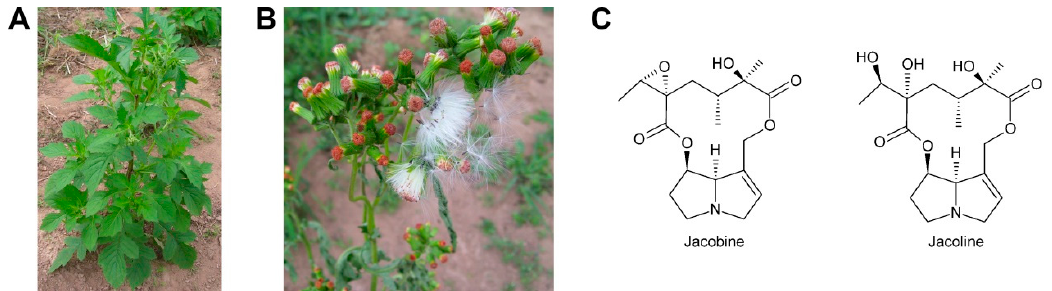
Figure 18. Crassocephalum crepidioides . C. crepidioides plant ( A ) and flowers ( B ). ( C ) The retronecine-type PAs jacobine and jacoline were reported in C. crepidioides . Pictures shown in ( A ) and ( B ): Courtesy of N. Adebimpe Adedej.